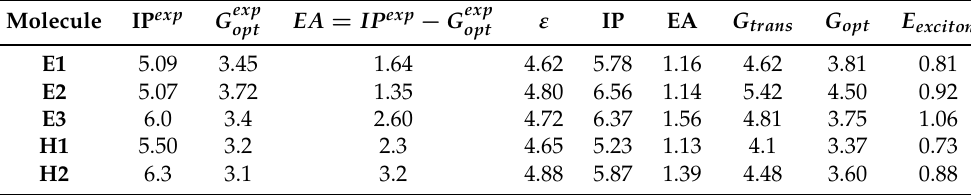
Table 4. Experimental data (superscript exp ) collected in reference [1] for the IP, EA, and optical gap (all in eV) of the five AOM investigated in this work. Theoretical results (last five columns) were obtained by means of DFT with the combination PBE0/Def2TZVPP and using PCM with the dielectric constant ε derived as explained extensively in the main text. G trans and G opt stand for transport and optical gap, respectively. The expression EA = IP exp − G exp is only exact when the optical and transport gap opt coincide, it i.e., the exciton binding energy is null (see beginning of Section 1).